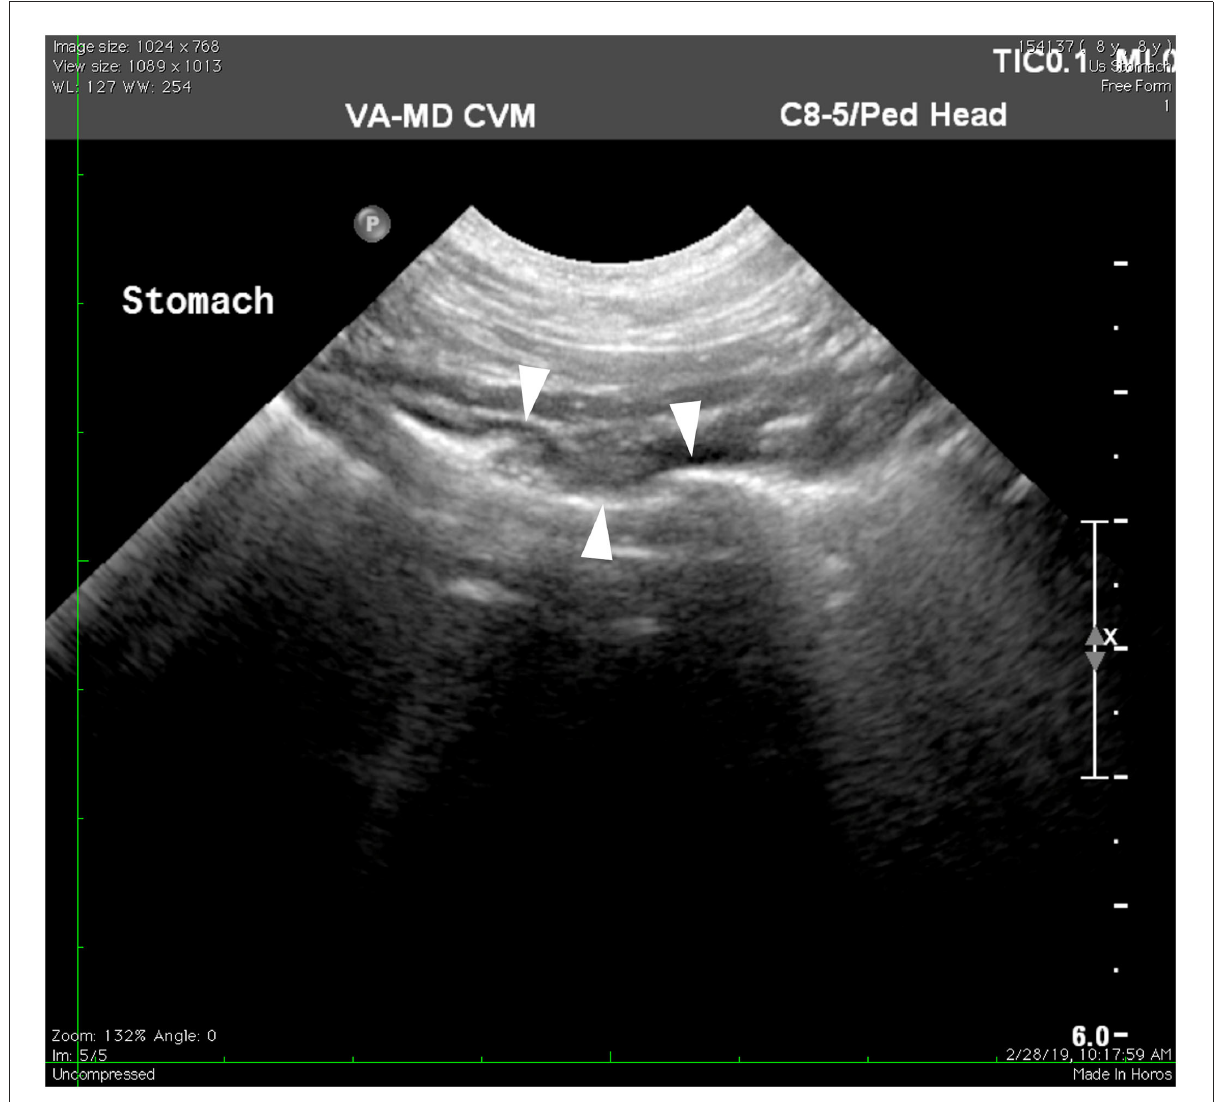
FIGURE4 Ultrasonography of the stomach 27 days after starting antimicrobial therapy. Previously described fundic lesions appear to no longer be present in the stomach wall (arrowheads).